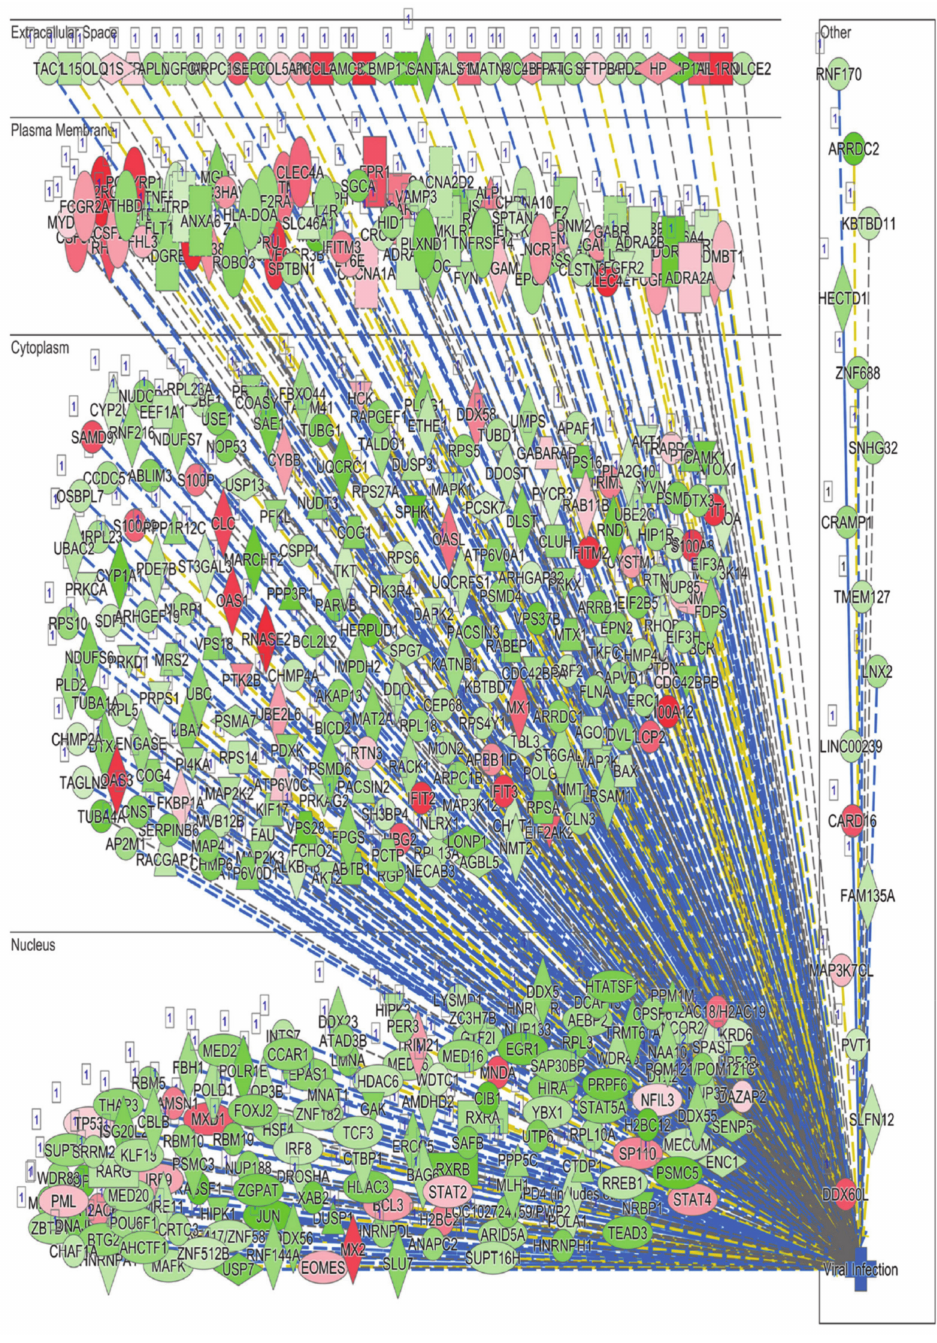
Figure 8. Illustration of the viral infection functional category according to subcellular localization based on transcriptome and IPA analysis of lung-derived tissue from COVID-19